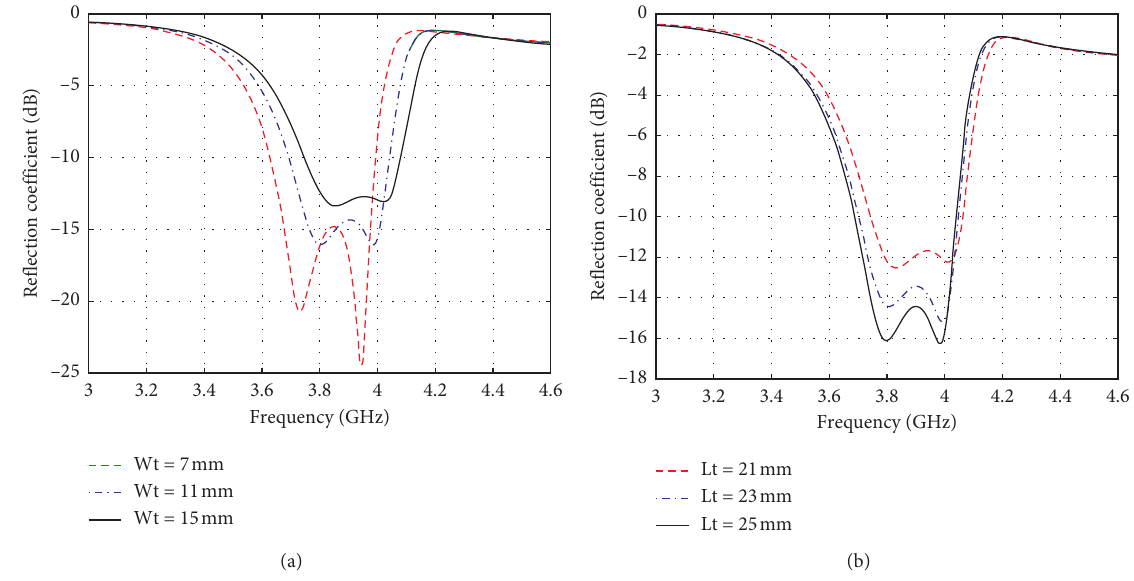
Figure 8: Variations in the reflection coefficient with changes in the (a) triangular slot width ( Wt ) and (b) triangular slot length ( Lt